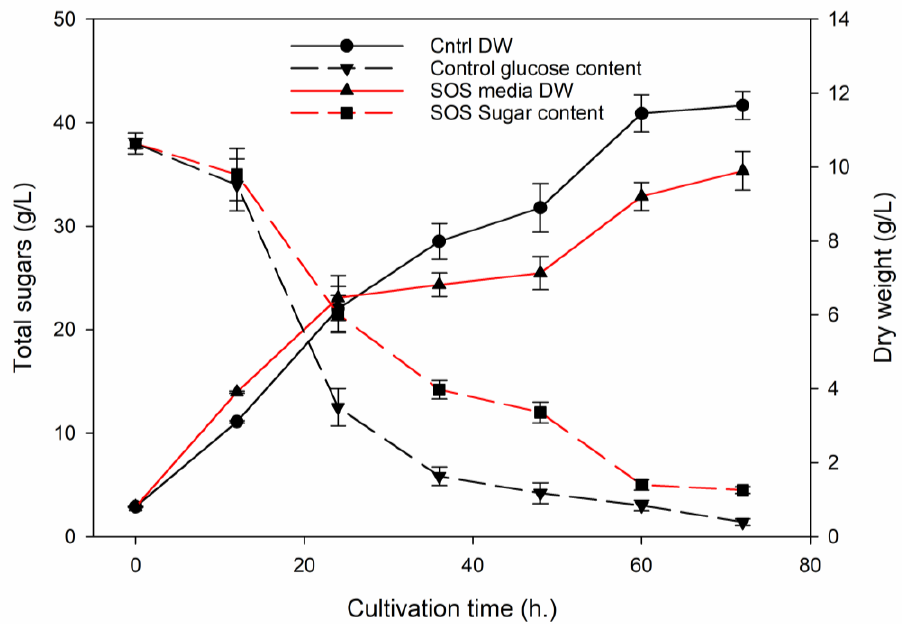
Figure 5. Growth curves and sugar consumption over time for A. mangrovei using the SOS optimized media compared to their relative control at the same C/N ratio using glucose. Values are reported as mean ± SD.